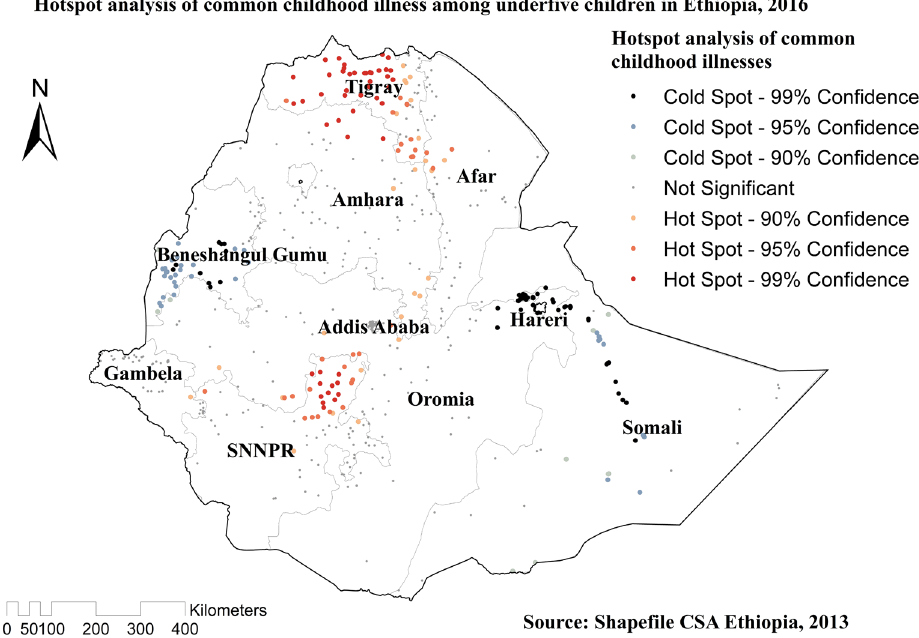
Figure 4. Hotspot analysis of common childhood illnesses among under-five children in Ethiopia, 2016 EDHS.